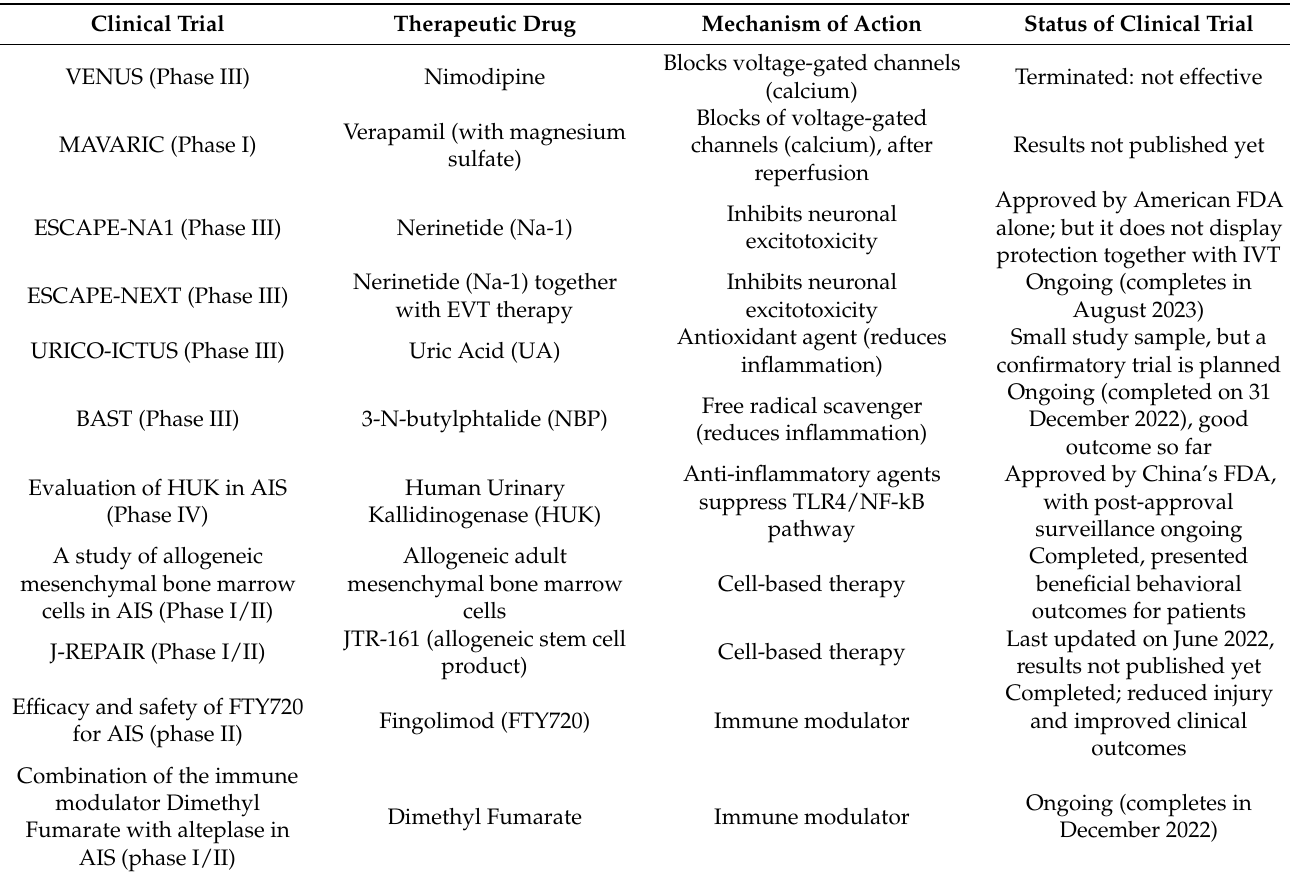
Table 1. Overview of recent clinical trials for cytoprotective therapies—phase, status, and mechanism of